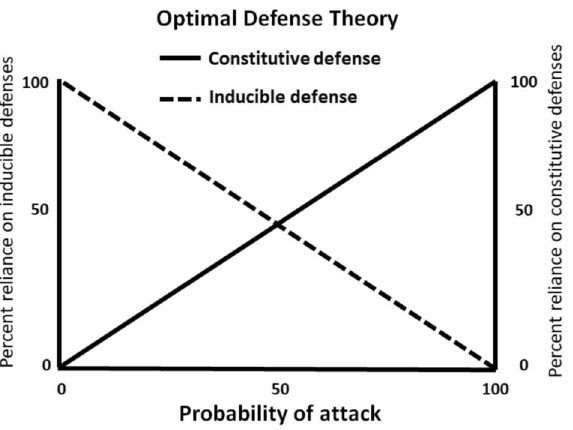
Figure 6. Optimal defense theory. Optimal defense theory predicts that tissues with a low probability of being attacked should rely primarily on inducible defenses, whereas those with a high probability of attack should rely primarily on constitutive